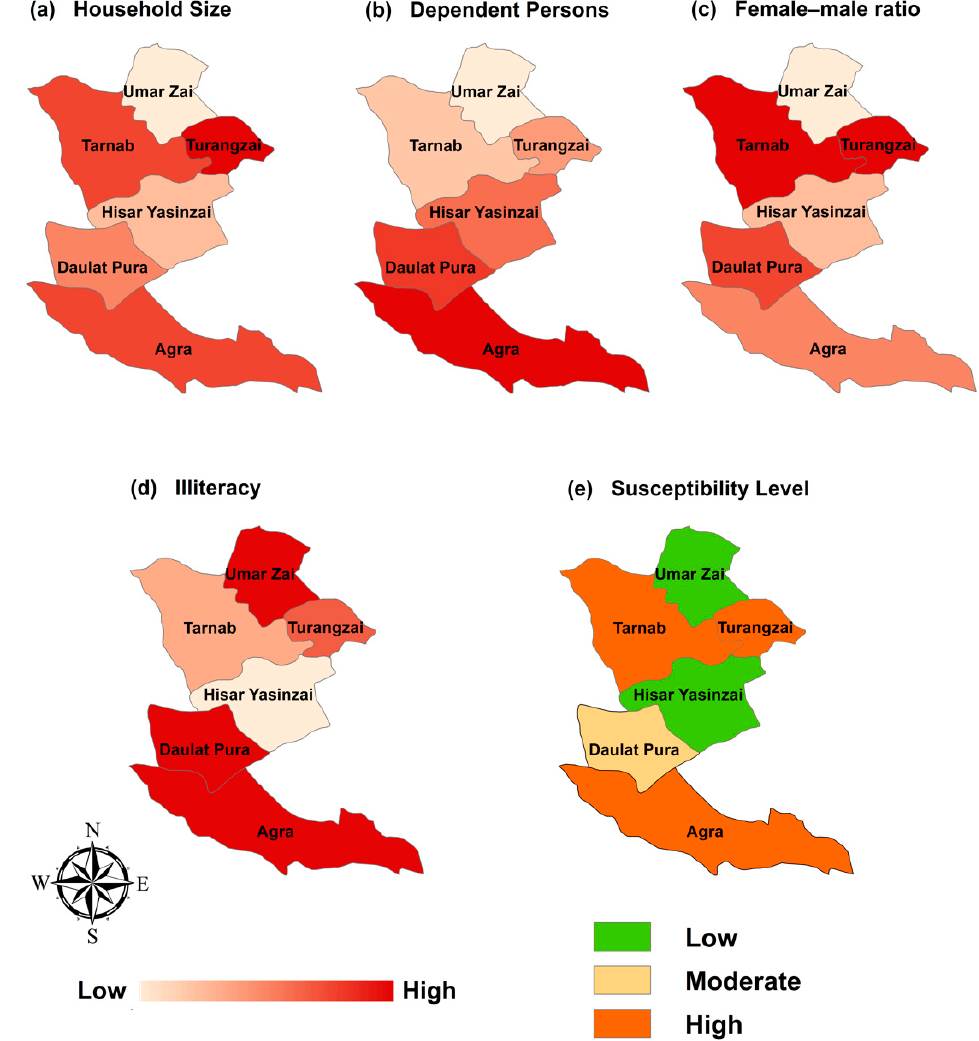
Figure 9. Geographical distribution of indicators and levels of susceptibility ( a ) represents the geo- graphical distribution of household size (>7 persons); ( b ) represents the geographical distribution of households with dependent persons (<14 years and >60 years); ( c ) represents the geographical distri- bution of households’ female–male ratio; ( d ) represents the geographical distribution of households with illiteracy; and ( e ) represents the geographical distribution of households’ susceptibility level). Table 5. Household susceptibility to floods.